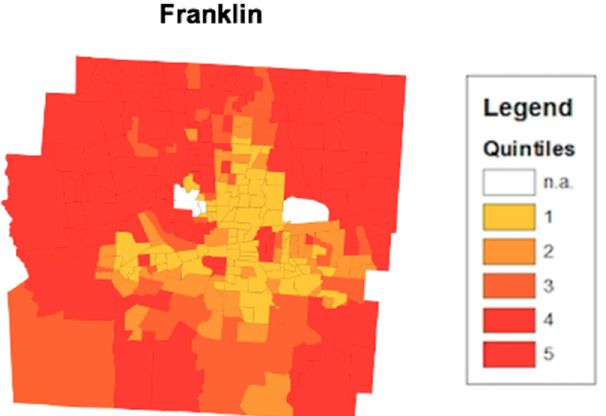
Figure 4. HOI Composite score map from Franklin County. The thematic map displays census tracts in Franklin County in central Ohio. The census tracts are color coordinated based on what quintile their HOI composite score falls in. The lower HOI Composite scores fall in the first quintile while the higher HOI scores fall in the fifth quintile.